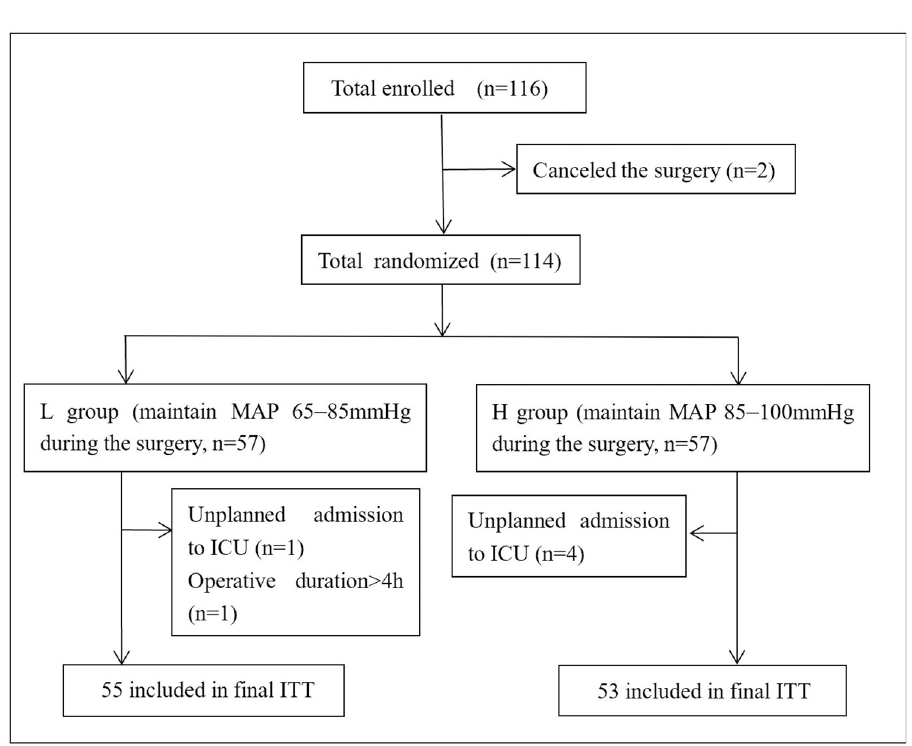
Fig 1. Trial profile. (ITT = intention-to-treat).